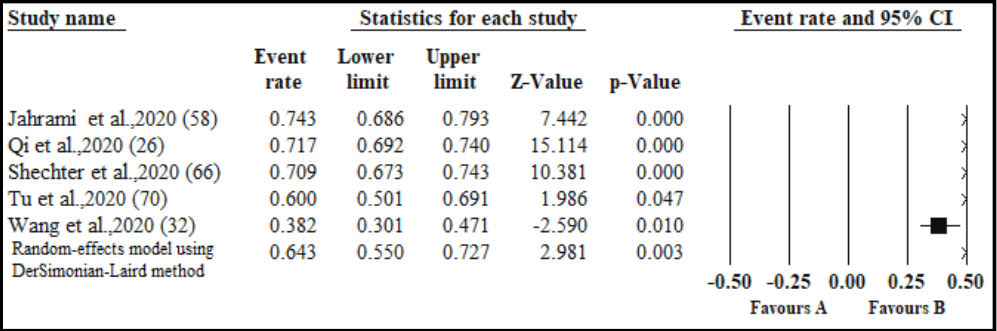
Figure A2. Forest plot for the studies on the prevalence of impaired sleep quality among healthcare workers. The squares and horizontal lines correspond to the study-specific event (anxiety) rates and 95% confidence intervals (CIs). The diamond represents the pooled prevalence and 95% CI of the overall population. The overall pooled impaired sleep quality using a random effects DerSimonian-Laird method was 64.3% (95% CI: 55.0–72.7).